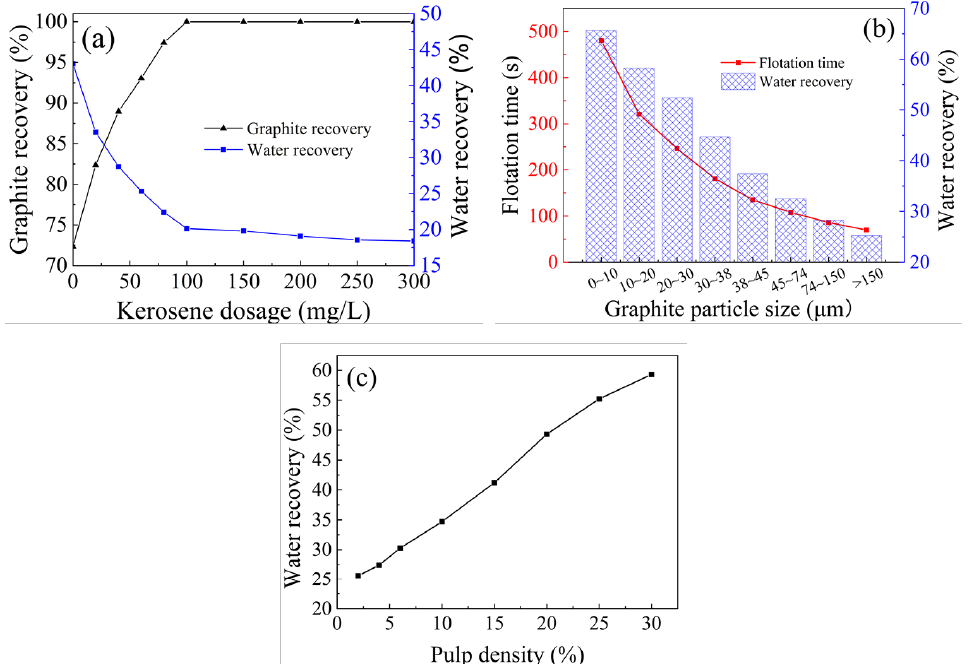
Figure 10. The effect of ( a ) kerosene dosage; ( b ) flake graphite particle size; and ( c ) pulp density on the water recovery in graphite concentrate.